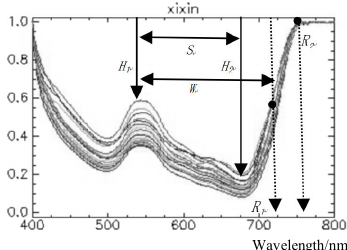
Figure 2. Reflectance spectrum character after continuum